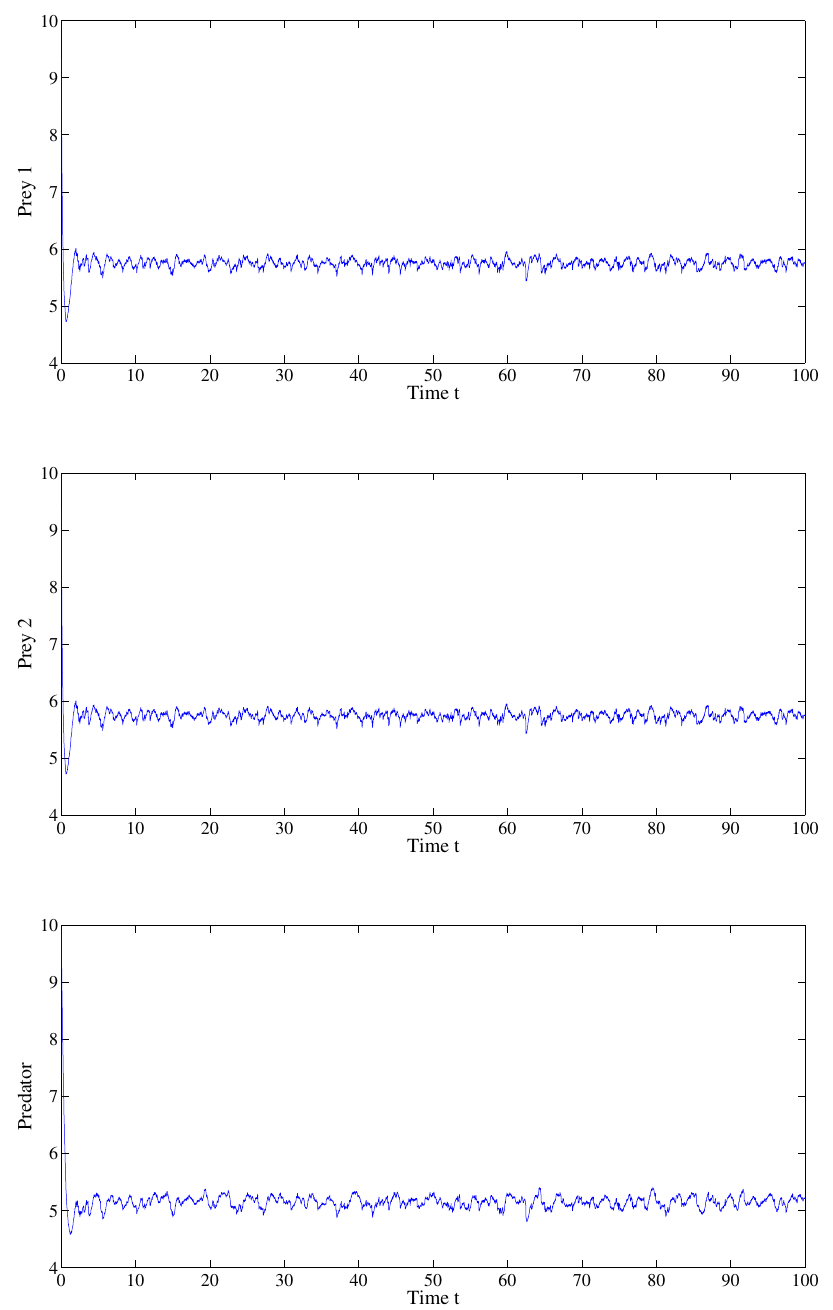
Figure 3. The behavior of the prey and predator populations in the case of persistence described by Theorem